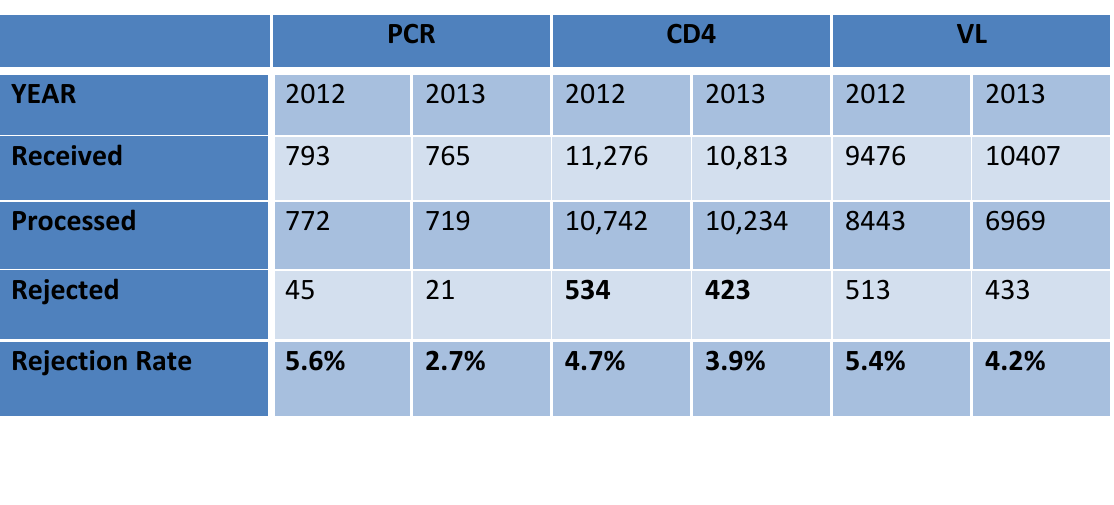
Table 4: Number of CD4 and PCR samples received, processed and rejected in 2012-